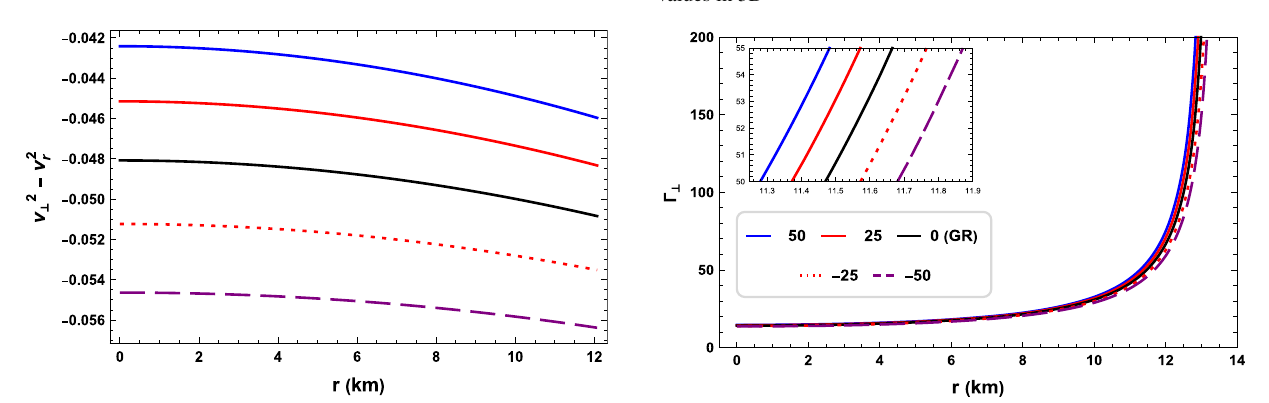
Fig. 9 Radial variation of square of the transverse sound velocity ( v 2 ⊥ ) for different α in PSR J0348+0432 in 5D